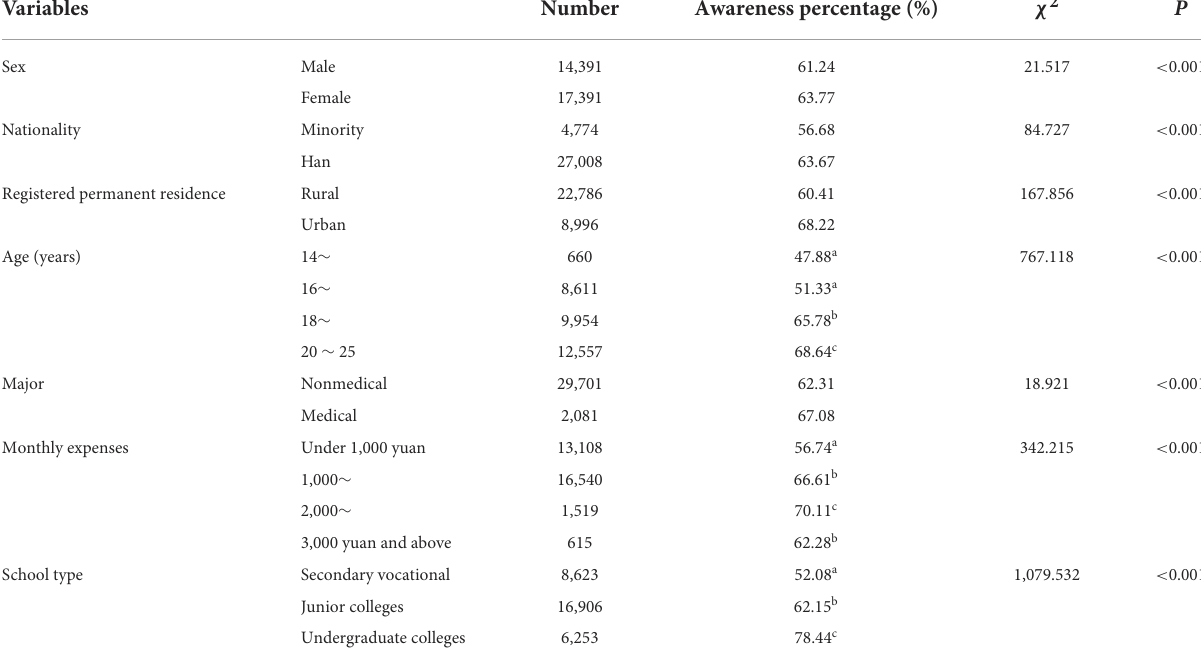
TABLE 3 HIV/AIDS knowledge among students with different characteristics ( n = 31,782). Variables